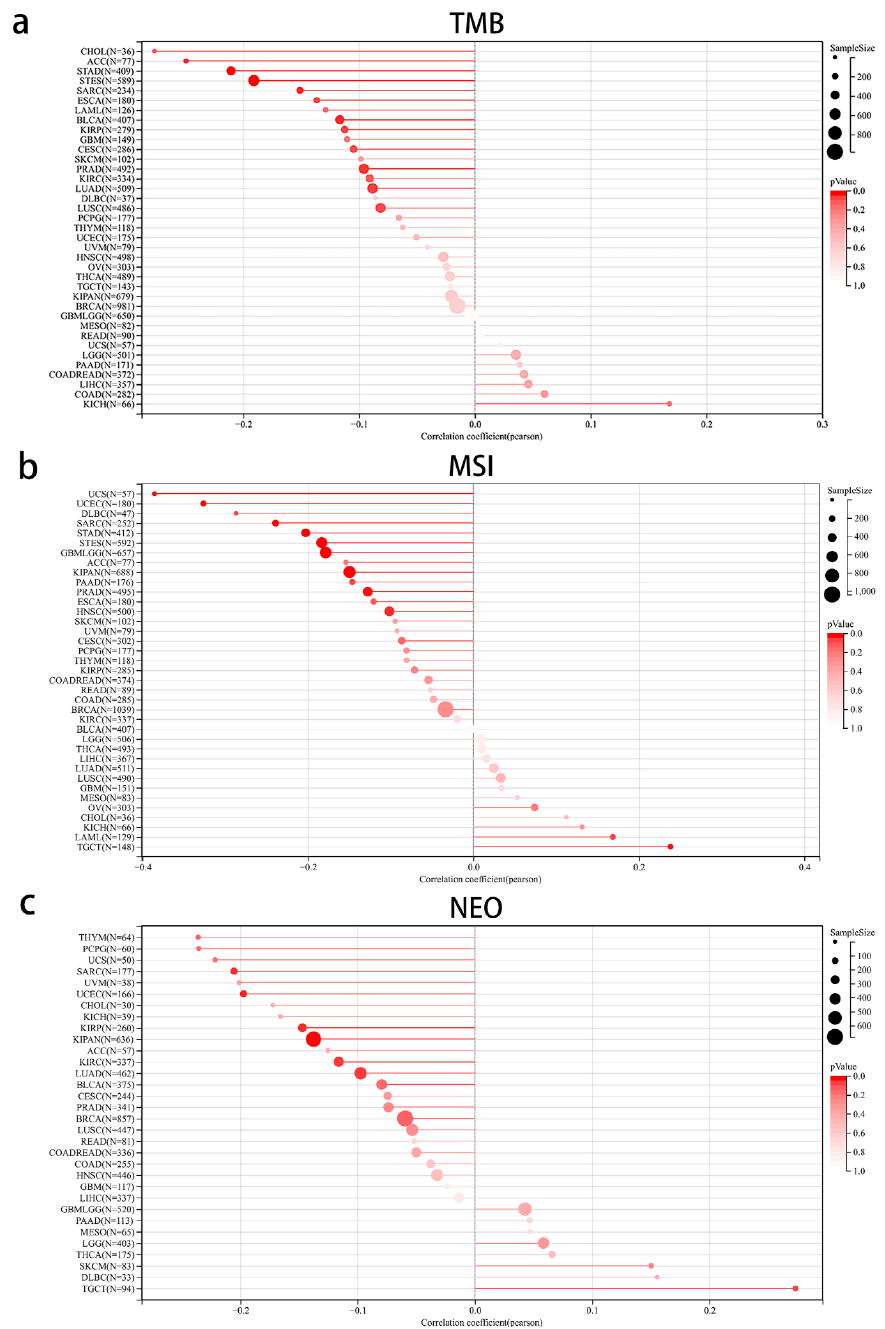
Figure 8. The relationship between MEIS1 expression and anti-immunity indicators ( a ) The relation- ship between MEIS1 expression and TMB ( b ) The relationship between MEIS1 expression and MSI. ( c ) The relationship between MEIS1 expression and